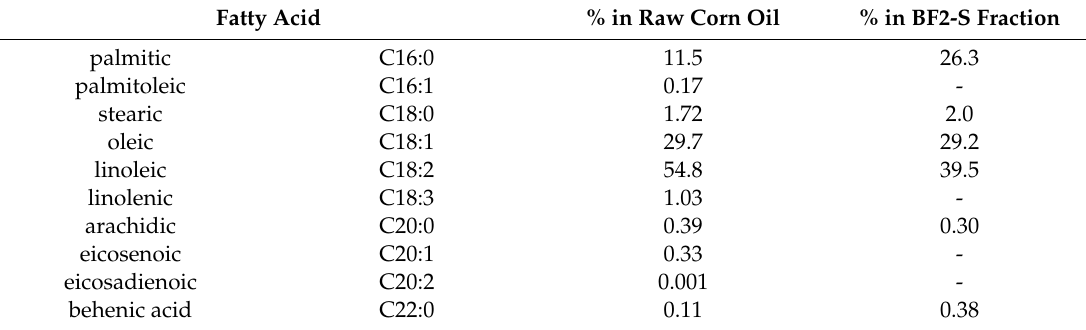
Table 3. Fatty acid composition of raw corn oil and BF2-S fraction (results obtained by GC analysis).